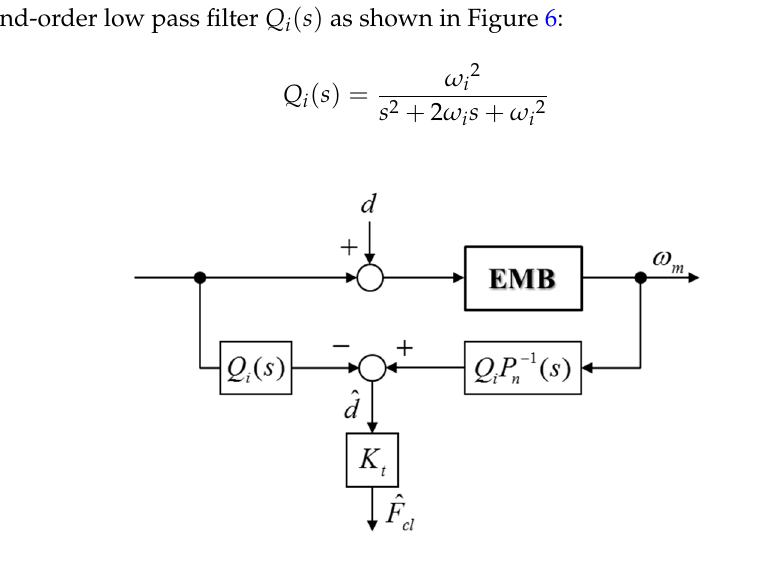
Figure 8. Structure of a two-degree-of-freedom position controller with a position-mode disturbance observer (P-DOB).